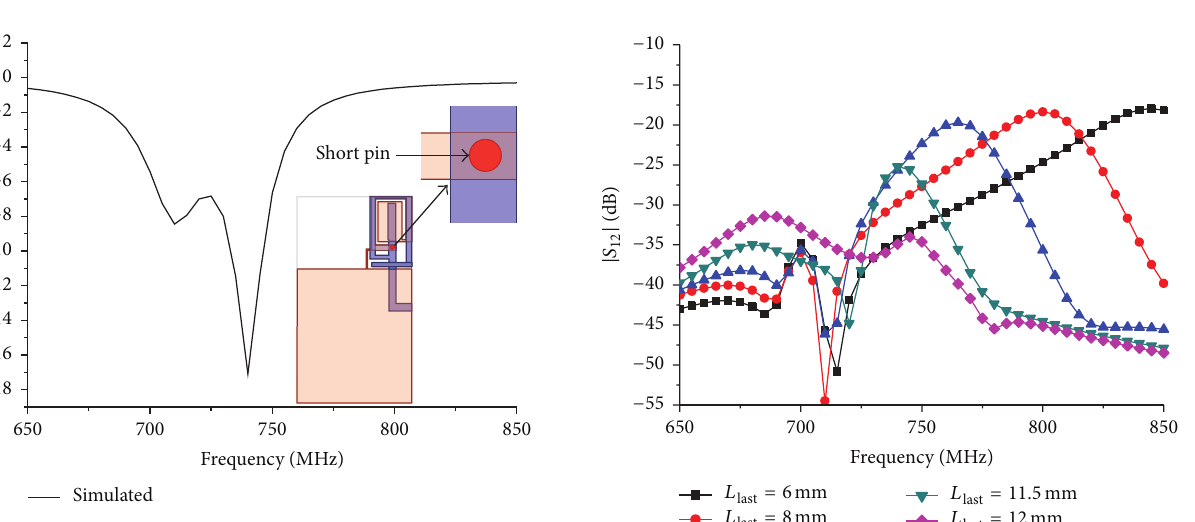
Figure 4: |𝑆 11 | curve of MIMO antenna element.